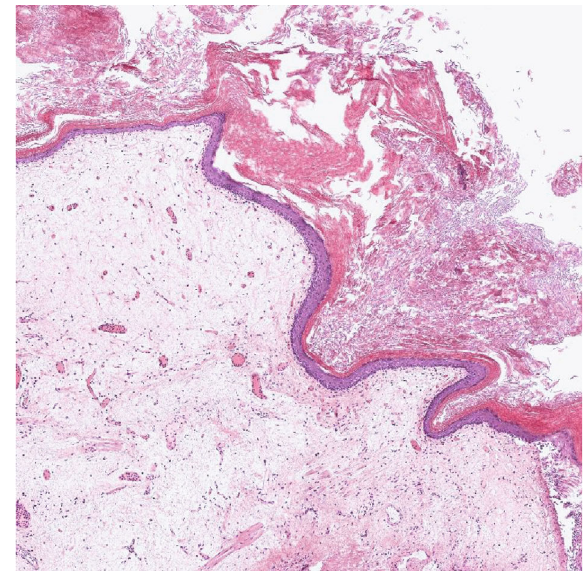
Figure 4: Replacement of the urothelium with strati fi ed keratinized squamous